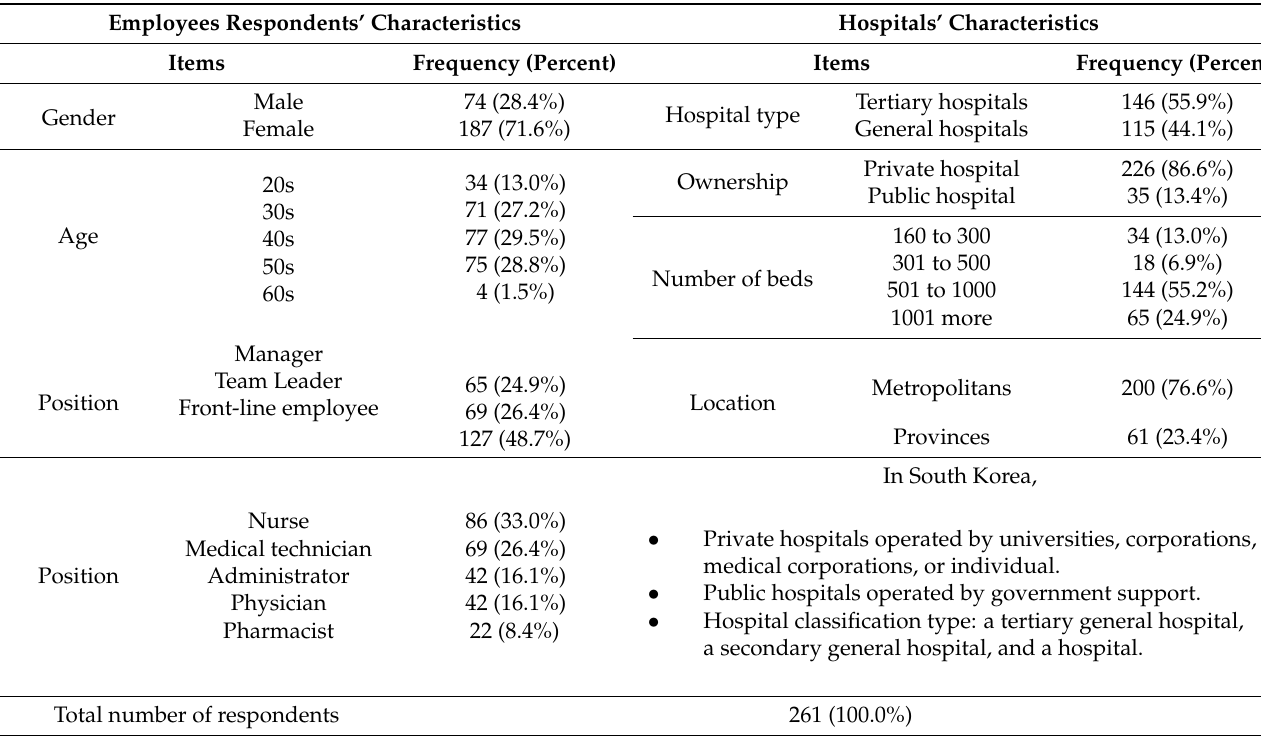
Table 3. Hospital characteristics and respondents’ demographic